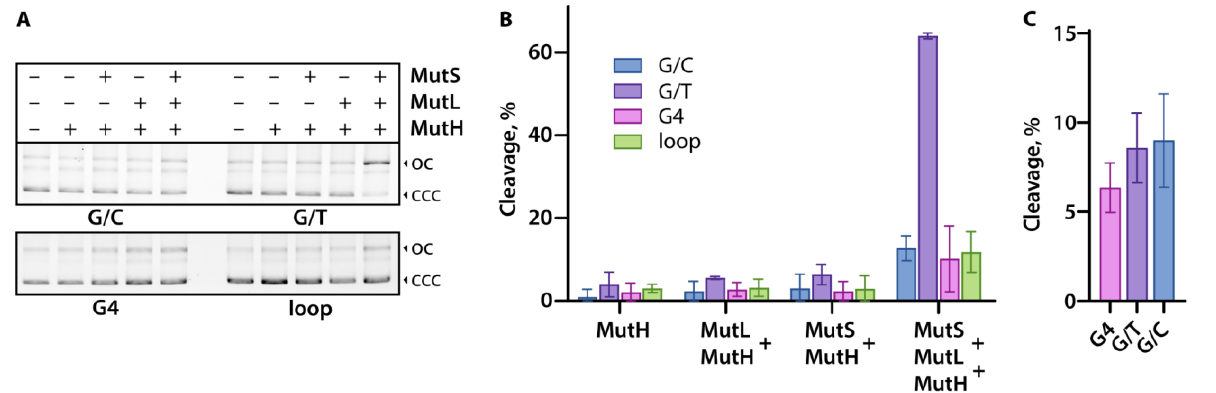
Figure 3. Cleavage of G4-pUC and control pUC plasmids (Table 2) by MMR proteins. ( A ) Cleavage products of the plasmid substrates G/C-pUC, G/T-pUC, G4-pUC, and loop-pUC, referred to as G/C, G/T, G4, and loop (10 nM), by E. coli MMR proteins were analyzed by electrophoresis in 1% agarose gel containing ethidium bromide; the positions of open circle (nicked) DNA (oc) and covalently closed circular DNA (ccc) are indicated on the right. The reaction mixtures were incubated in the buffer solution containing 1 mM ATP, 5 mM MgCl 2 , and 120 mM KCl for 1 h at 37 ° C in the presence of 100 nM ecMutH alone, 100 nM ecMutH and 250 nM ecMutL and/or 250 nM ecMutS (all protein concentrations are calculated per monomer). ( B ) Efficiency of plasmid hydrolysis induced by ecMutH alone and combinations of ecMutH with ecMutS and/or ecMutL. Reaction conditions are indicated in panel ( A ). ( C ) ngMutL- induced (1 μM per monomer) hydrolysis of plasmid sub- strates (10 nM). The reaction mixtures were incubated in the presence of 5 mM MnCl 2 , 50 mM KCl for 1 h at 37 °C, and then electrophoresed in 1% agarose gel containing ethidium bromide.